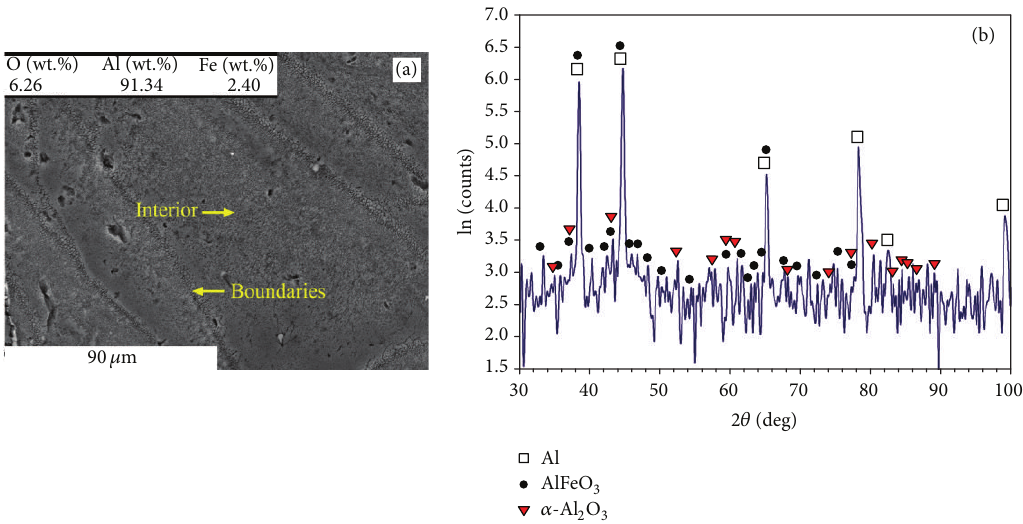
Figure 8: (a) Microstructure and (b) XRD pattern of the part made by 𝑃 = 91 W, V = 0.5 m/s, and 𝑡 = 50 𝜇